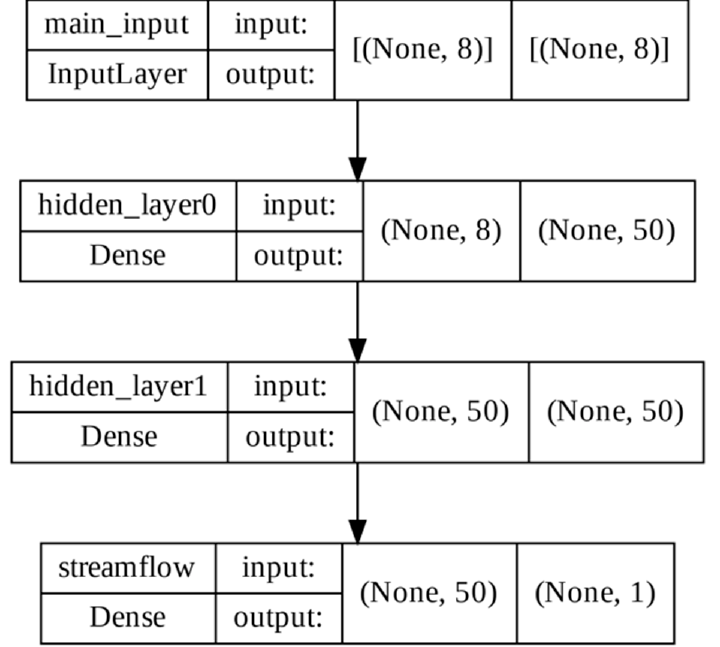
Figure 3. Data processing flowchart for FFNN-3 regionalization model. “None” represents the batch size, which is only decided in the training phase.